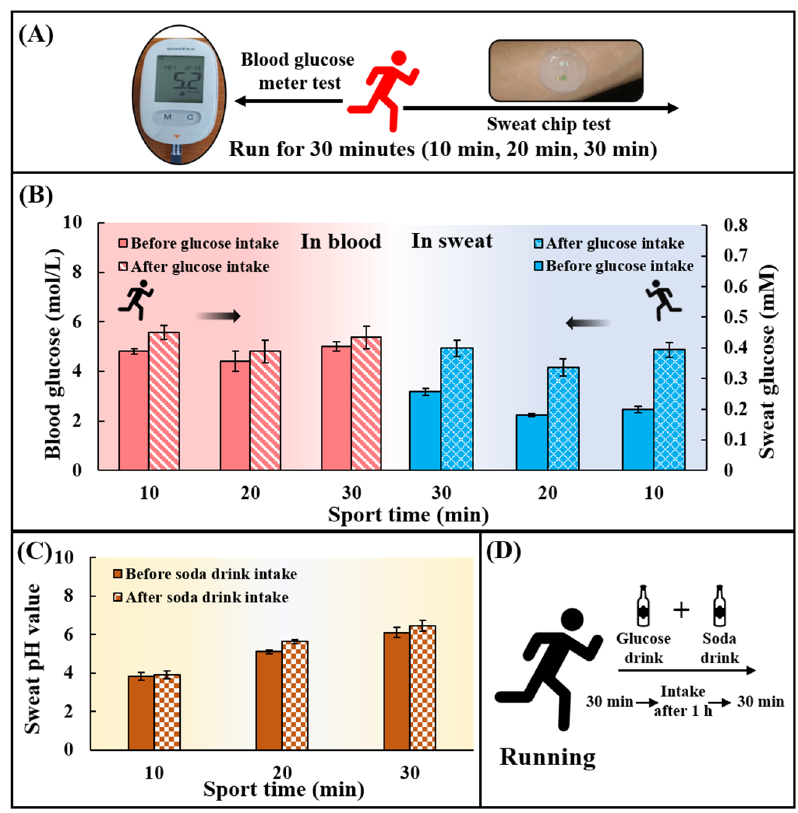
Figure 5. Practical application of the chip for sweat glucose and pH detection during exercise. ( A ) Blood glucose levels and sweat glucose concentrations were detected at 10, 20, and 30 min during exercise using a blood glucose meter and a sweat chip. ( B ) Changes in blood glucose and sweat glucose concentrations at 10, 20, and 30 min during exercise. ( C ) Changes of sweat pH value at 10, 20 and 30 min during exercise. There are two phases: before consuming the soda drink and after consuming the soda drink. ( D ) Replenishment of sports drinks. 250 mL of a drink containing 50 g of glucose was taken together with 375 mL of a soda drink with pH = 7.8 ± 0.4.